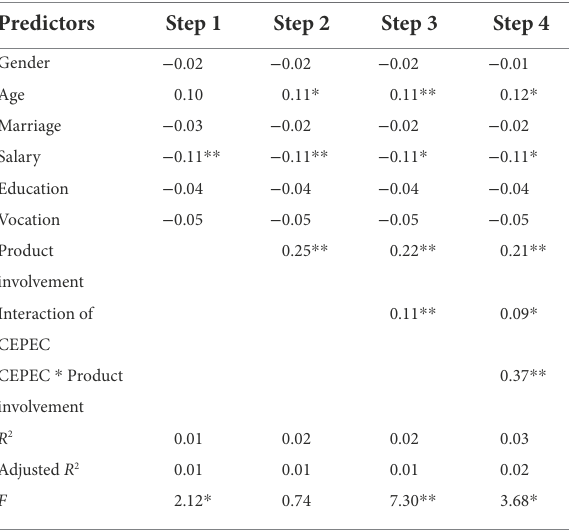
TABLE 3 Results of product involvement as a moderating role between virtual anime endorser-product congruence and attitude toward the brand.